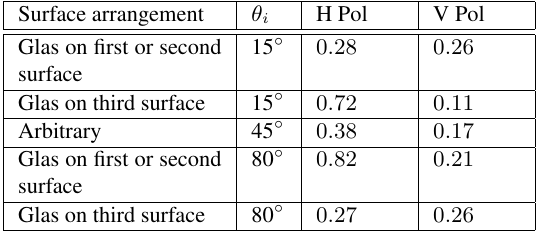
Table 2. Reflection component resulting at two metallic sur- faces and one glass surface coated by 10 percent silver (no signal loss: 1) for different local signal incidence angles ( θ i ) on first surface. Permittivity parameters assumed for C-